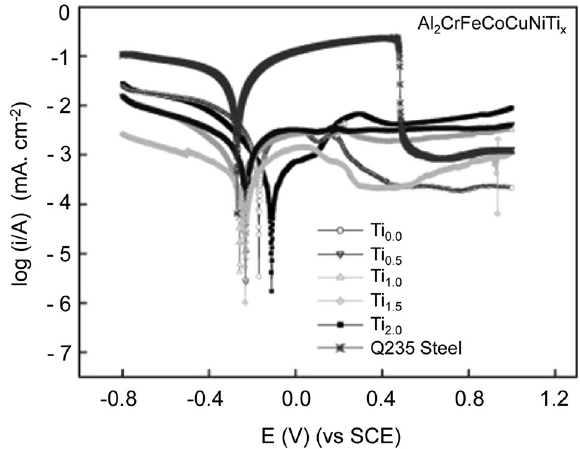
Fig. 6 The potentiodynamic polarisation curves for the Al 2 CrFeCo- CuNiTi x system and Q235 steel (roughly equivalent to ASTM A36 mild steel) in 0.5 mol/l HNO 3 (reprinted from ref. 37 with permission